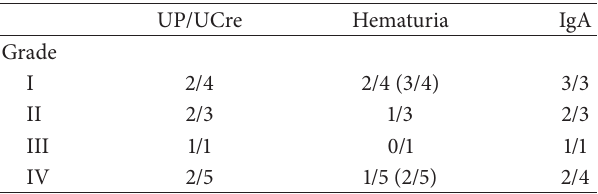
Table 3: The improvement rate one month postsurgery compared to presurgery in terms of renal